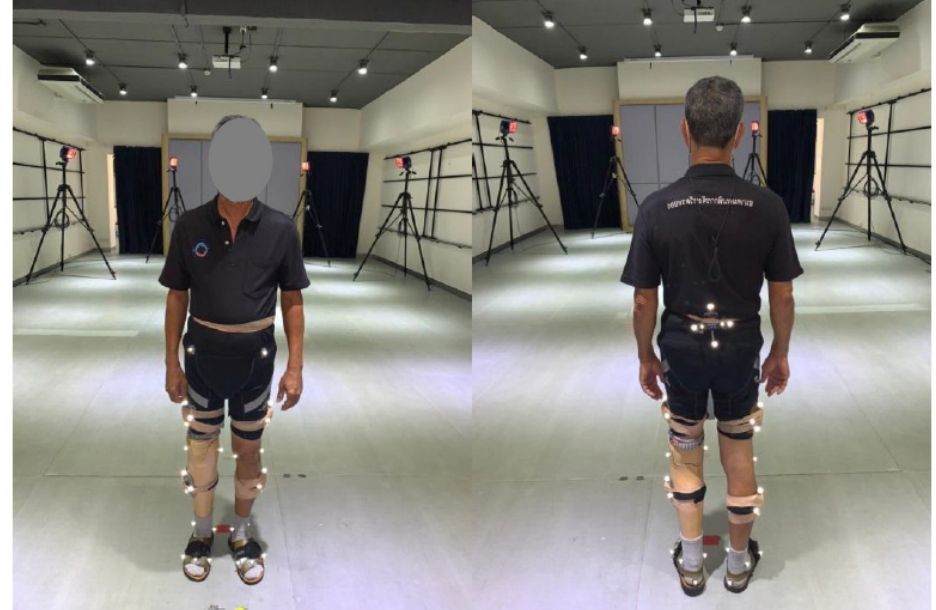
Figure 2. Image displaying a single comprehensive set for two systems, Inertial measurement unit (IMU) and cluster-based marker (CBM) set of optical motion capture system (OMC).